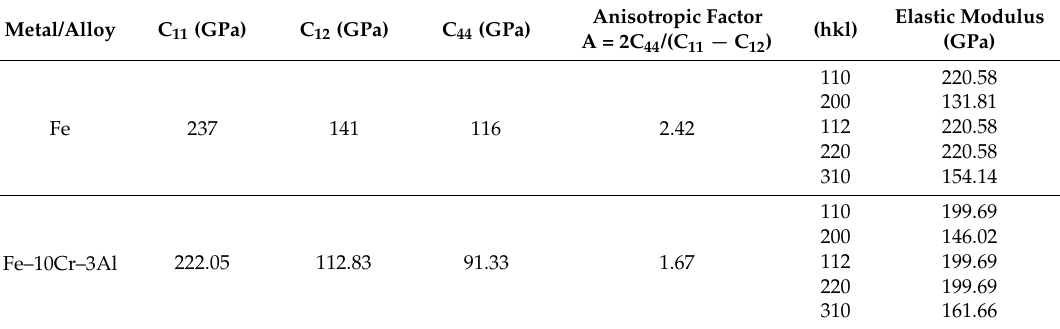
Table 1. Elastic constant, elastic modulus, and anisotropic factor for Fe and Fe–10Cr–3Al alloy.